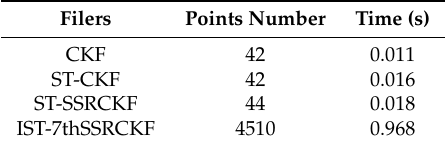
Figure 8. The velocity error in smooth stage ( left ) and maneuvering stage ( right ) from different filters. Table 3. Number of points and computation complexity of different filter for each run.